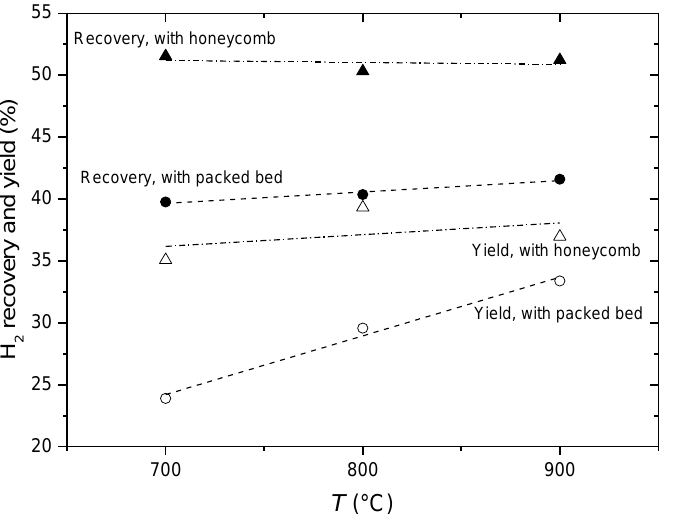
Figure 13. Comparison of the efficiency characteristics for CMRs with packed bed and honeycomb catalysts at the flow rates for the feed gas of 5 Nl h − 1 and for the sweep gas of 10 Nl h − 1 . The feed gas: 4.0% of EtOH at S/E = 4 in Ar for honeycomb catalyst; 6.6% of EtOH at S/E = 5 in Ar for the fixed bed.